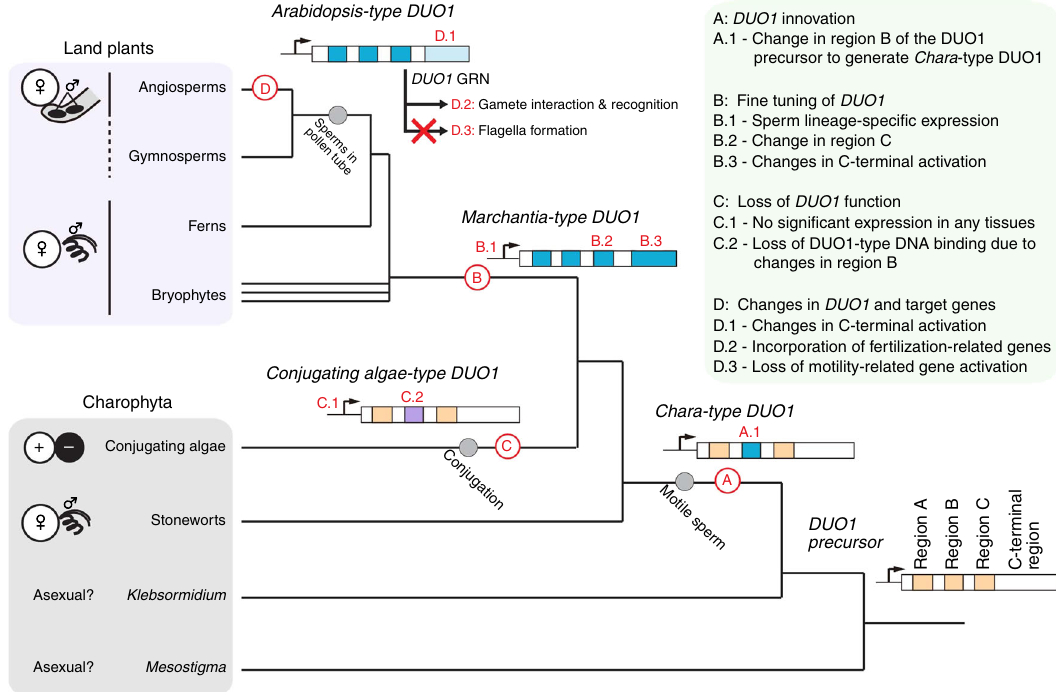
Fig. 8 A model for DUO1 evolution during green plant evolution. DUO1 arose from a pre-existing MYB TF in an ancestor of stoneworts by acquiring a DUO1- type feature in region B of its MYB domain (A.1). DUO1 innovation in ancestral plants promoted a speci fi c program of differentiation of male gametes. Before the emergence of land plants, the sperm lineage-speci fi c expression of DUO1 was acquired (B.1) and a change in region C occurred to re fi ne DNA- binding speci fi city (B.2), which has been conserved among land plants. The DUO1 C-terminal domain also underwent large changes, presumably adapting its transcription activation function for individual species during evolution (B.3). In conjugating green algae, the DUO1 ortholog is no longer expressed in the sperm lineage (C.1) and has accumulated mutations in the MYB domain (C.2), resulting in a loss of DUO1 function. During land plant evolution, the DUO1 C-terminal activation domain has been modi fi ed, establishing lineage-speci fi c activity (D.1). In seed plants, DUO1 retained its DNA-binding speci fi city and other male gamete-related genes, such as those important for fertilization, were recruited to (D.2) and motility-related genes were removed from (D.3) the set of genes controlled by DUO1, leading to signi fi cant rewiring of the DUO1 regulatory network. Modes of sexual reproduction are shown on the left 37 . Sexual reproduction is unknown in Mesostigma , and Klebsormidium . Note that some gymnosperms ( Ginkgo and cycads) have fl agellate sperm cells delivered by a pollen using Ultracut UCT (Leica) and the sections were mounted on copper grids. They were stained with 2% uranyl acetate at room temperature for 15min, and then they ducts were separated on a 2.5% (w/v) agarose gel, stained with ethidium bromide, were washed with distilled water followed by being secondary-stained with Lead and visualized under UV light. The primers used in these experiments are listed in stain solution (Sigma-Aldrich) at room temperature for 3min. The grids were Supplementary Table 3. For quantitative RT-PCR analysis, the cDNA samples were observed by JEM-1400Plus (JEOL Ltd.) at an acceleration voltage of 80kV. Digital diluted with 220 µl of distilled water and 2 μ l aliquots were ampli fi ed with the images were taken with a CCD camera, VELETA (Olympus). Immuno fl uorescence staining . The fi xation and permeabilization of antheridia according to manufacturer ’ s protocol. The primers used in these experiments are were carried out essentially according to previous report 53 . Isolated spermatid cells listed in Supplementary Table 3. Mp ACT1 was used as an internal control. were incubated with a polyclonal anti-centrin antibody against a recombinant protein corresponding to a full-length centrin from a brown alga Scytosiphon Genetic complementation assay on At duo1 and Mp duo1-1 ko . For Arabidopsis lomentaria (a gift from Dr. Taizo Motomura, Hokkaido University, Japan) diluted complementation assay, mature pollen grains from WT and T3 stable homozygous 1:500 with PBS [137mM NaCl, 2.68mM KCl, 8.1mM Na 2 HPO 4 , and 1.47 mM KH 2 PO 4 , pH 7.4] in a moist chamber for 90min at 37°C. After a PBS wash, incubation with a monoclonal anti α -tubulin (T5168, Sigma) diluted 1:500 with cellular pollen grains was determined by scoring the number of respective pollen PBS was performed for 60min at 37 °C. After a wash again with PBS, the samples grains by DAPI staining. The ability of H3.10 activation was assessed by counting were incubated for 60 min at 37 °C with an equal mixture of Alexa 488-conjugated the frequency of pollen grains expressing mRuby2 fl uorescence marker in sperm goat anti-rabbit IgG (H + L) (A11034, Invitrogen) diluted 1:200 with PBS and ( pro At HTR10:HTR10-mRuby2 ). Alexa 568-conjugated goat anti-mouse IgG (H + L) (A11031, Invitrogen) diluted For Marchantia complementation assay, the discharged sperm was directly 1:200 with PBS. After washing with PBS for 10min, the nuclei were stained with 1 observed without fi xation on a Miniscope TM3000 (HITACHI, Japan) to obtain μ g ml − 1 DAPI in PBS. Slides were mounted using Vectashield (Vector Laboratory) scanning electron microscopic images. To observe the nuclear morphology of and observed using a confocal laser scanning microscope (FV-1000, Olympus). sperm, the discharged sperm were stained with DAPI and observed under a confocal microscope (FV-1000, Olympus) with the following setting: DAPI was Quantitative RT-PCR analysis . Total RNA was extracted with an RNeasy Plant excited by 405-nm laser and detected by a photomultiplier tube with 425 − 475-nm Mini Kit (QIAGEN) according to the manufacturer ’ s protocol and the quality and quantity of the resultant RNA were evaluated using a NanoDrop 2000c spectro- photometer (ThermoFisher Scienti fi c). One μ g of total RNA was reverse- transcribed in a 20 μ l reaction mixture using Transcriptor (Roche). After the reaction, the mixture was diluted with 180 μ l of distilled water and 2 μ l aliquots were used for PCR in a 10 μ l PCR reaction mixture containing 1 μ l of 10× Ex Taq